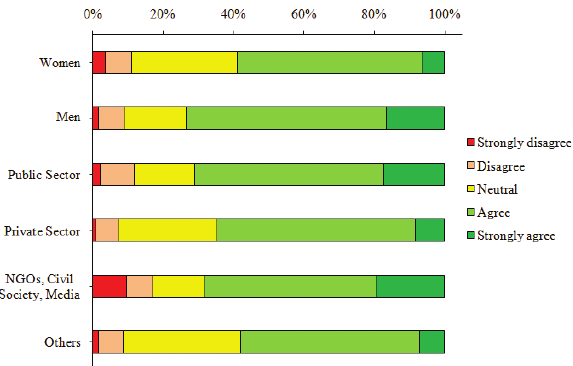
Figure 5. Gender and occupation-wise responses to statement B4: “Nuclear power plants can meet present energy crisis in